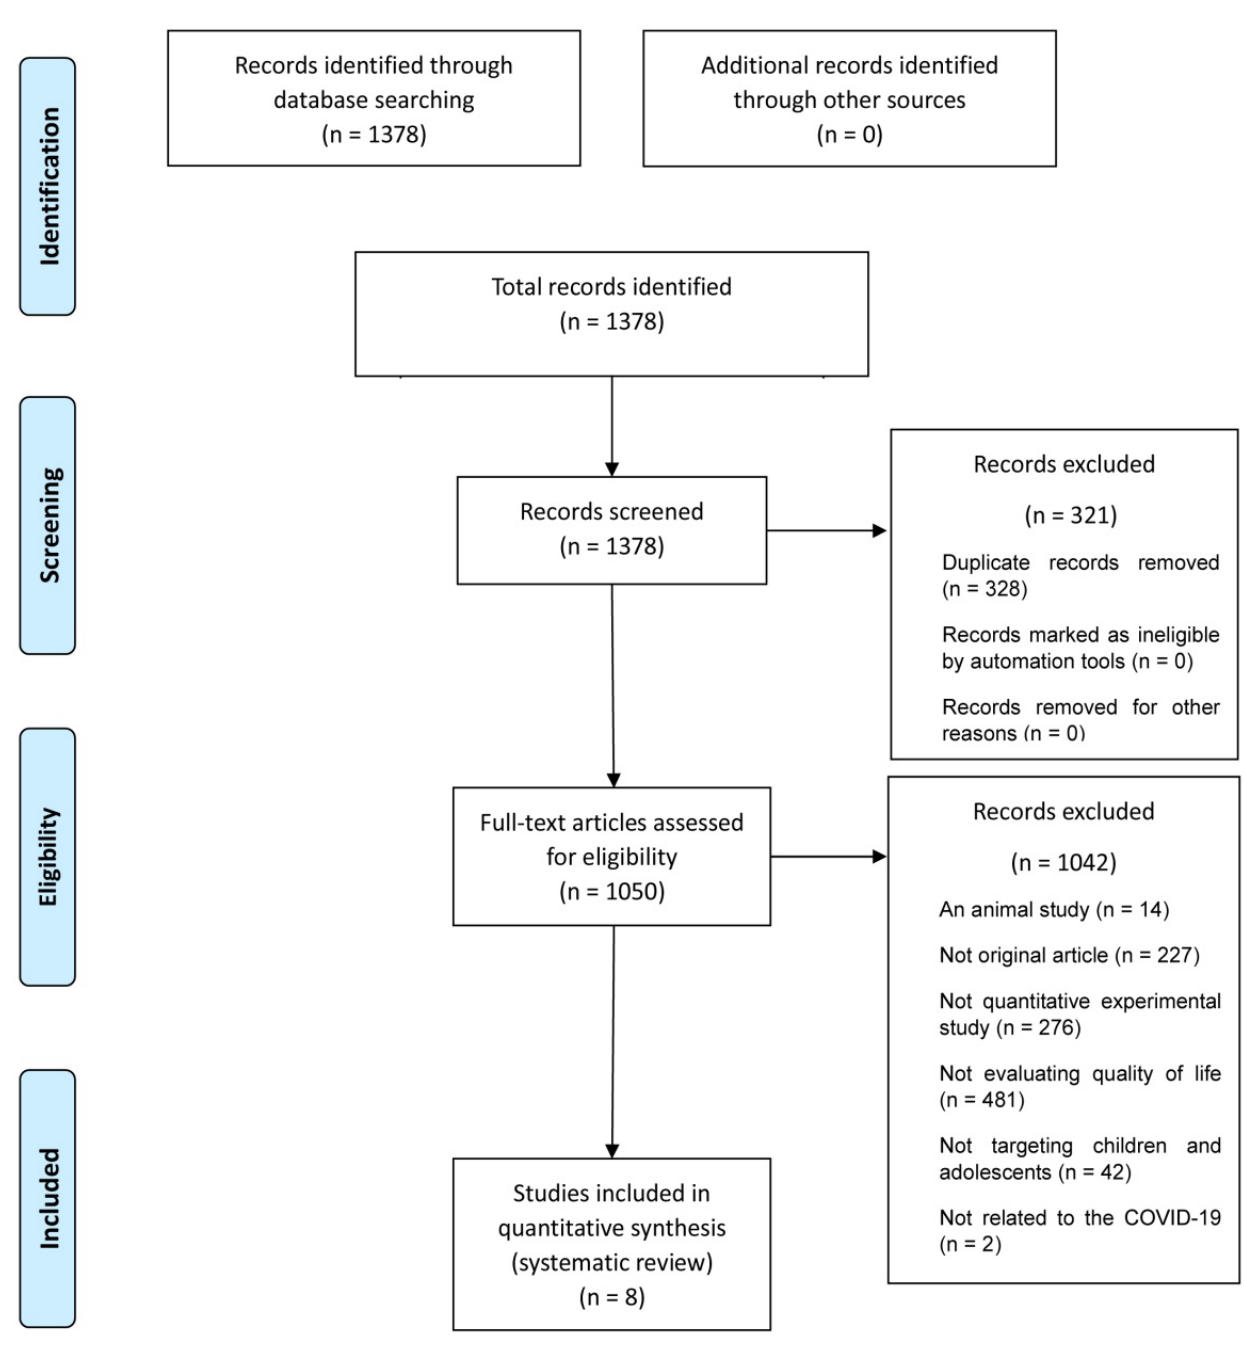
Figure 1. PRISMA flow diagram.